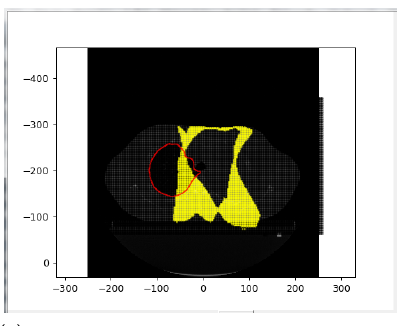
( c ) Lung contour selected with the dose range. ( d ) Calculation results for a given range and selected contour. The area of interest us colored in pink. Figure 23. The possible visualization of the CT